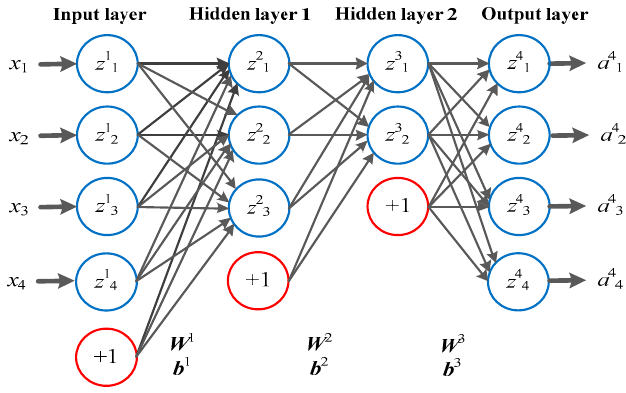
Figure 2. Topology structure of a simple Auto-Encoder (AE).